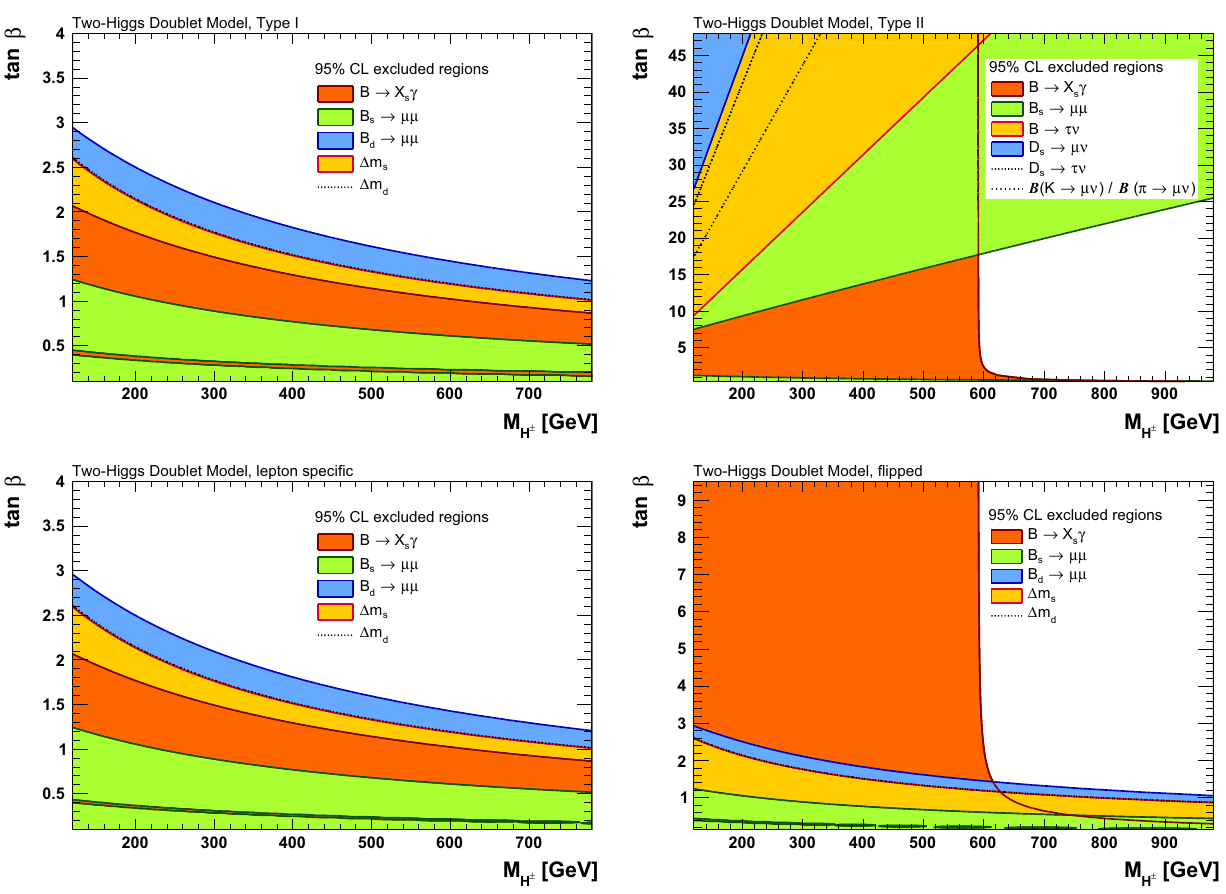
Fig. 9 Excluded parameter regions (95% CL) in the tan β versus M H ± plane from individual observables for the four 2HDM scenarios considered: Type-I (top left), Type-II (top right), lepton specific (bottom left), flipped (bottom right) on the Type-II model are also obtained from B ( B s → μμ) .